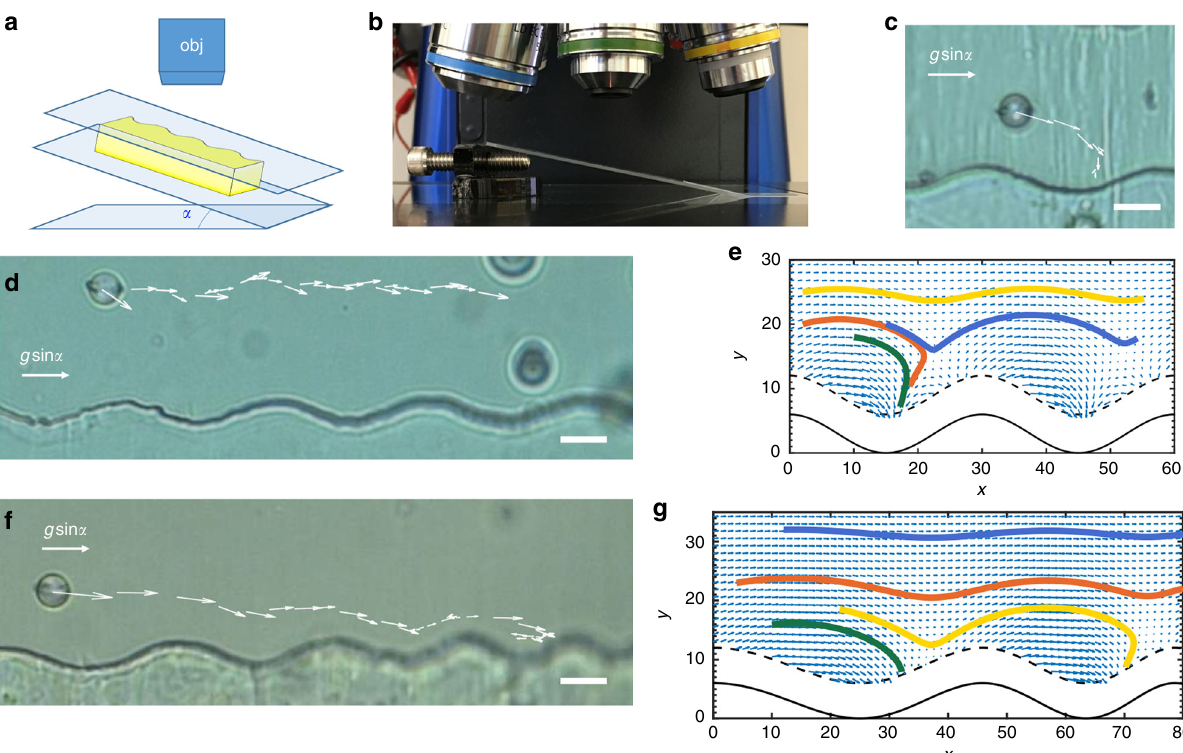
Fig. 8 A “ Goldilocks ” colloid in motion docks in a preferred well. a Schematic of the experimental setup with tilt angle α to harness gravity to drive colloid motion in x direction. b Image of the setup which allows fi ne control of the tilt, and thus the x -component of gravity g sin α . c A colloid traveling with x -directed velocity V x = 0.01 μ ms − 1 at tilt angle α = 11.2°. d A colloid traveling at V x = 0.06 μ ms − 1 at tilt angle α = 12.3°. e Particle trajectories at various initial loci predicted for the sum of the elastic energy fi eld and a gravitational potential energy gradient in - x direction across uniform set of wells ( λ = 70 μ m). f A colloid traveling at V x = 0.09 μ ms − 1 at tilt angle α = 12.8° across wells of decreasing wavelengths ( λ = 70, 60, 50, 40 μ m). g Particle trajectories predicted for the sum of the elastic energy fi eld and a gravitational potential energy gradient in - x direction. All colloids have 2 a = 13 μ m. The scale bars are 20 μ